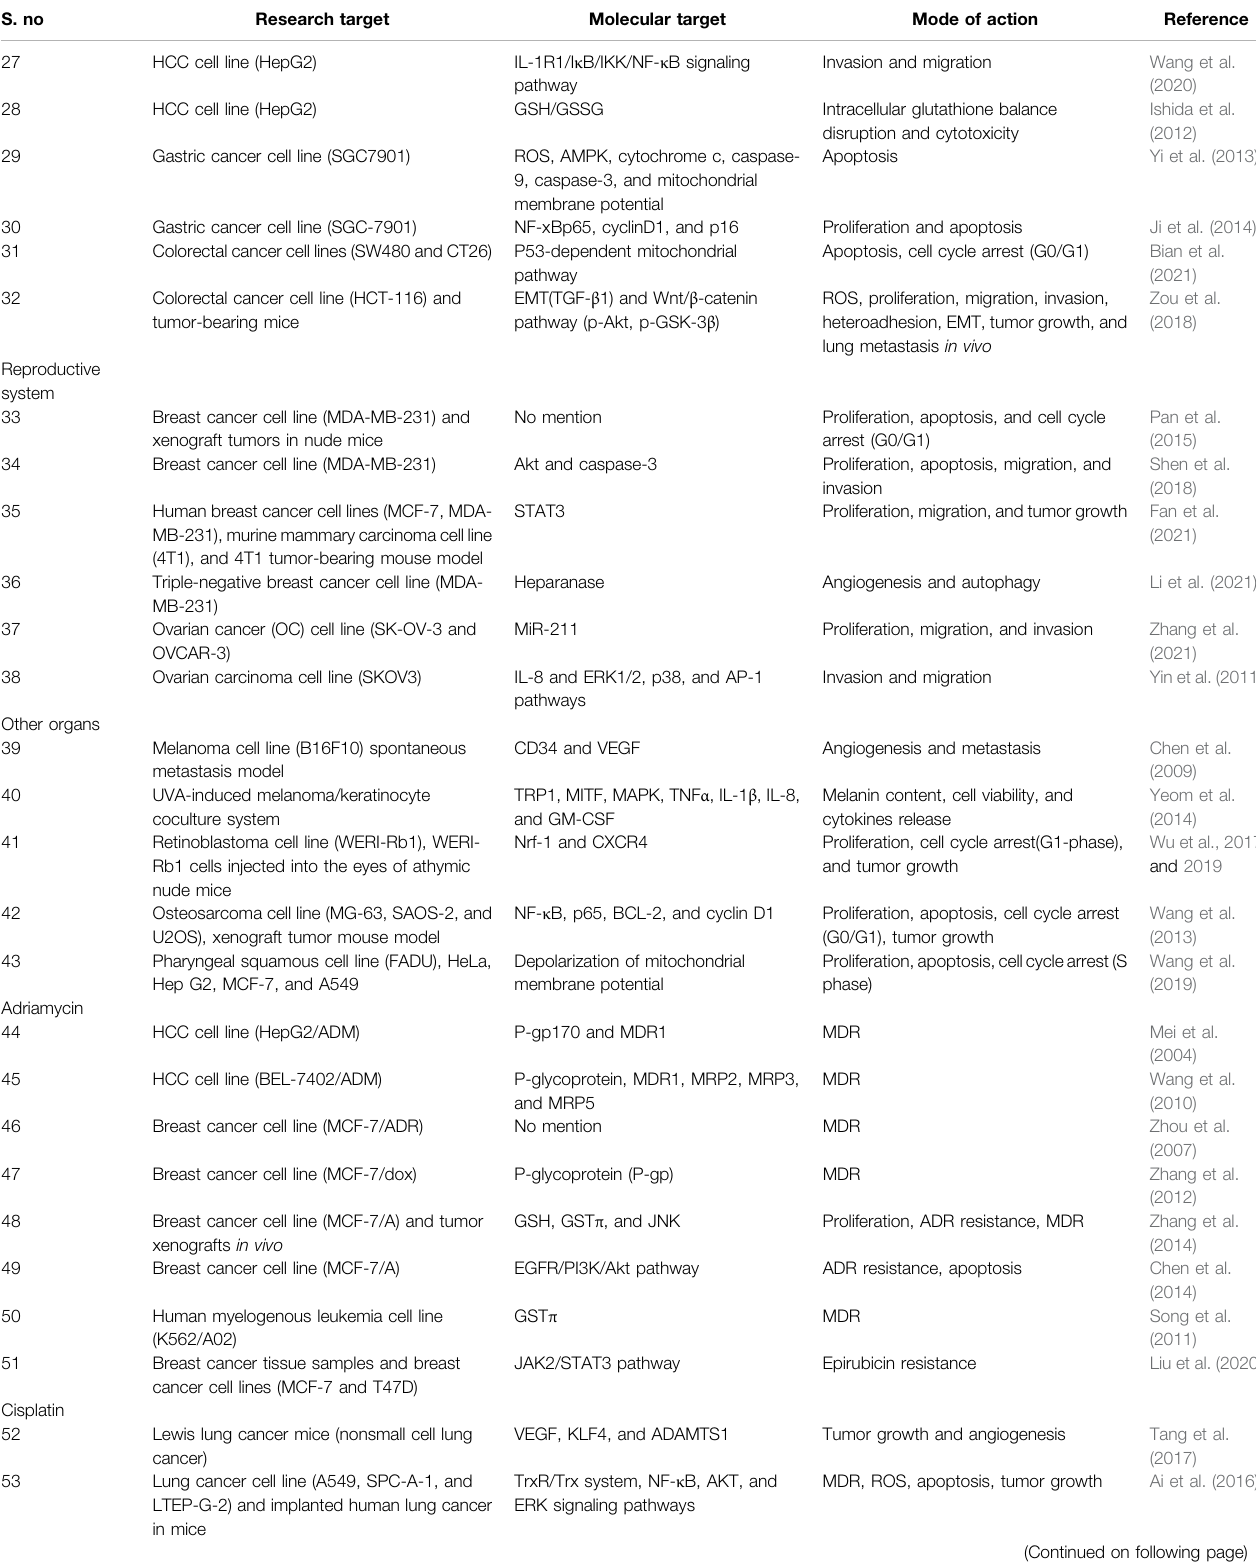
TABLE 2 | ( Continued ) Antitumor effect of tetramethylpyrazine against the tumor models of multiple